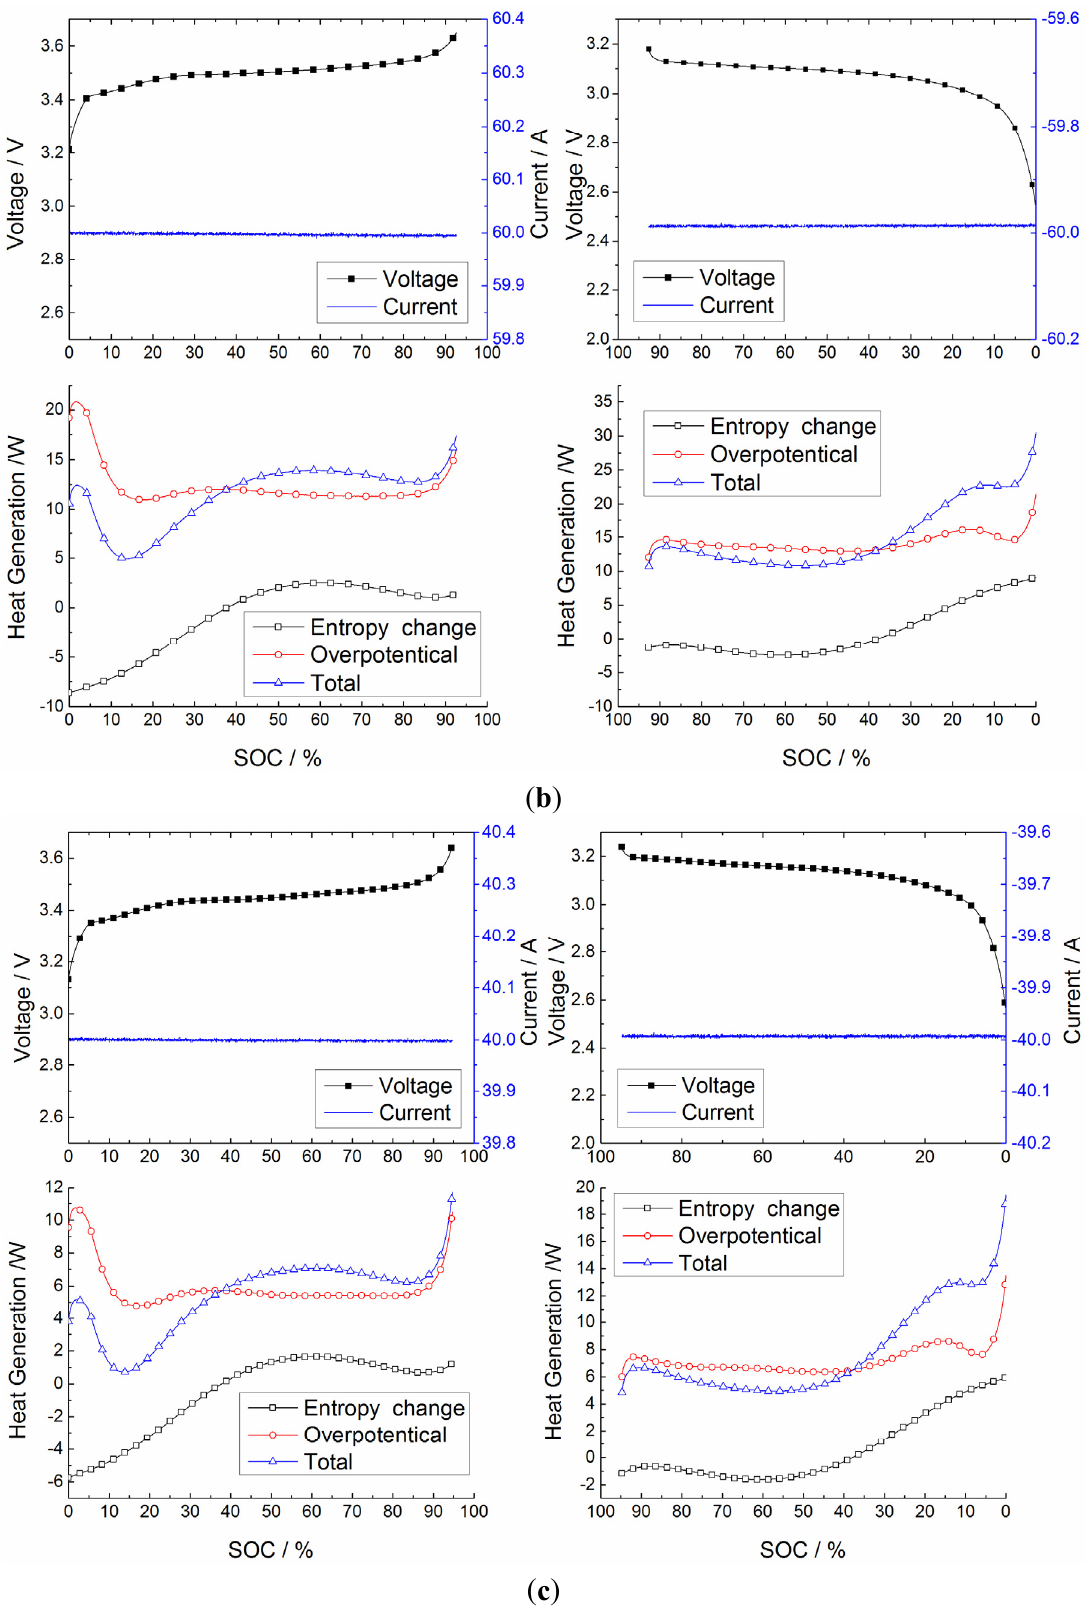
Figure 7. Heat generation for 3 charge/discharge current rates ( a ) 2 C current rate heat generation; ( b ) 1.5 C current rate heat generation; ( c ) 1 C current rate heat